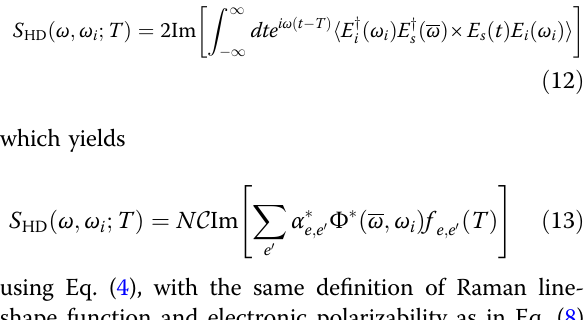
Femtosecond spectroscopy with entangled light: Heterodyne-detected QFRS We let the s -arm photons serve as a local oscillator interfering with the emitted photons, so that the inter- ference can be recorded in the detectors. This may be achieved by a beam splitter which directs a portion of the photons in s arm to propagate freely and subsequently mix with the emission. This is in a fashion of Mach- Zehnder (MZ) interferometer, as depicted in Fig. 1b. The fi eld directed into detector 1 carries the superposition state e j i þ e i ϕ e 0 j i assuming 50/50 beam splitters. The joint detection of photons with anti-Stokes shift yields the Þ . In such a spirit, we fi nd the measurement / Re ð e (cid:2) i ϕ ρ e ; e 0 heterodyne-detected signal explicitly through the trans- mission of the probe (Supplementary section S2) S HD ð ω ; ω i ; T Þ ¼ 2Im